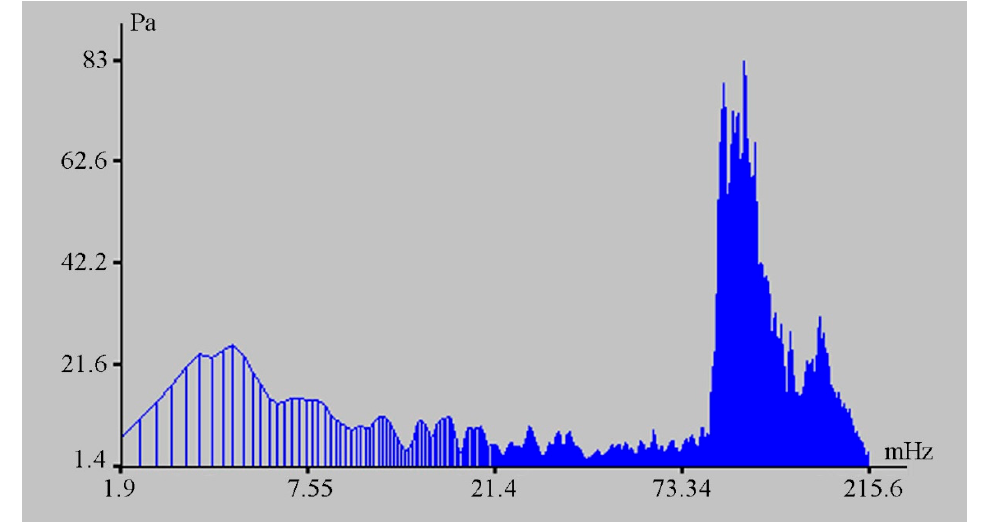
Figure 10. Spectrum of the detector of hydrosphere pressure variations record fragment.